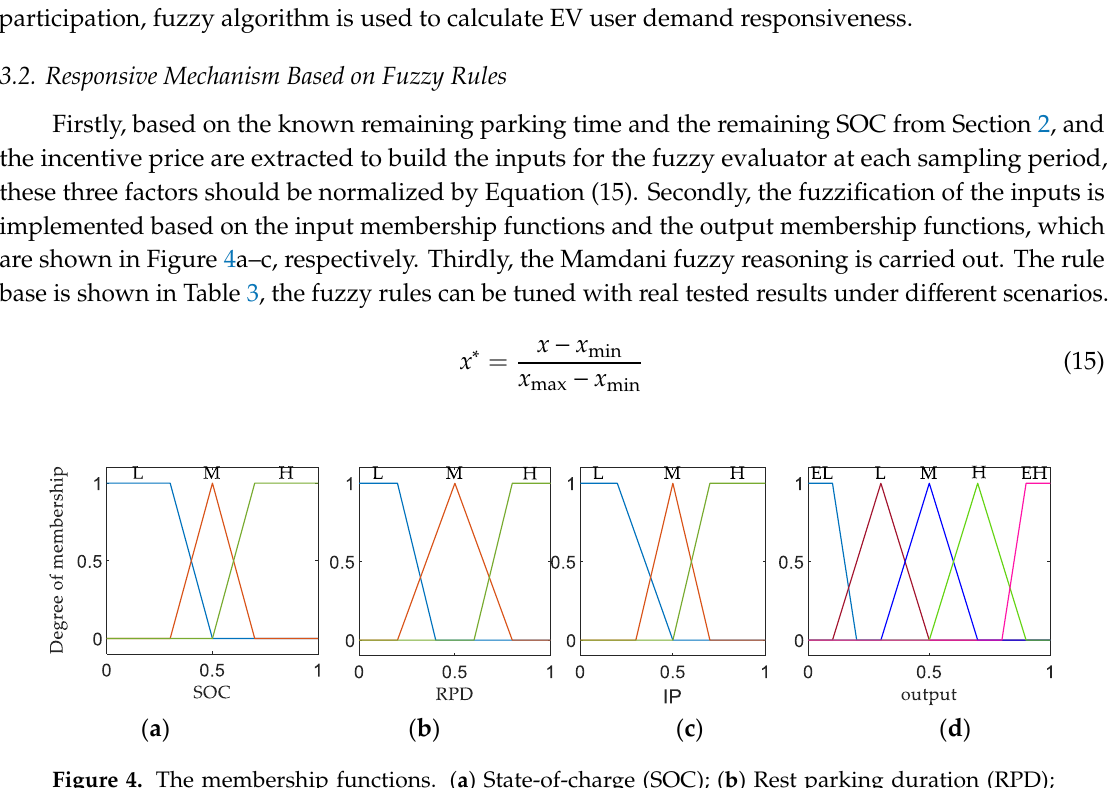
Figure 4. The membership functions. ( a ) State-of-charge (SOC); ( b ) Rest parking duration (RPD); ( c ) Incentive price (IP); ( d ) Output membership functions (EV-DR participation). Table 3. Rule base and defuzzification.